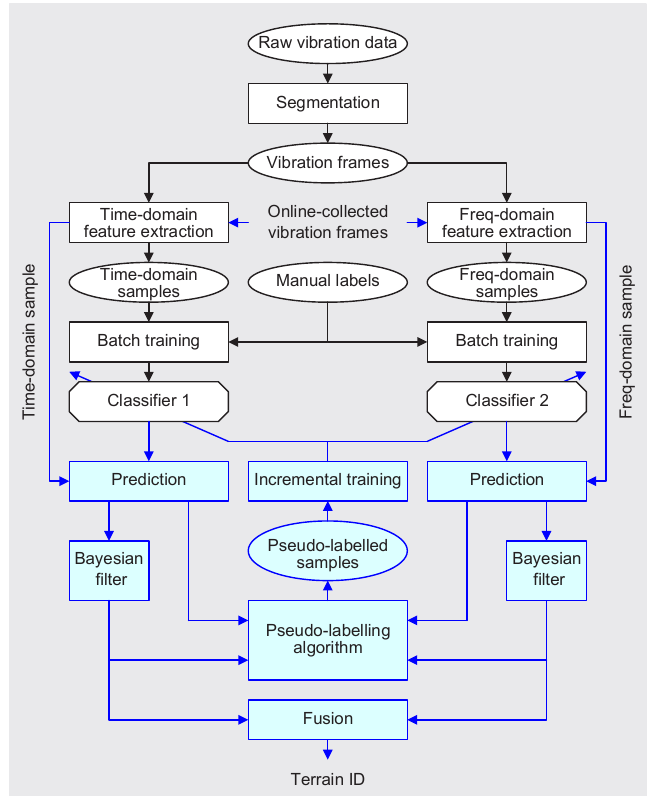
Figure 1. Frameworkoftheproposeddynamicvibration-basedterrainclassification(DyVTC).Therectangular and elliptical blocks represent operations and dataset , respectively. The rectangles without corners represent models . We use the color blue to highlight the online